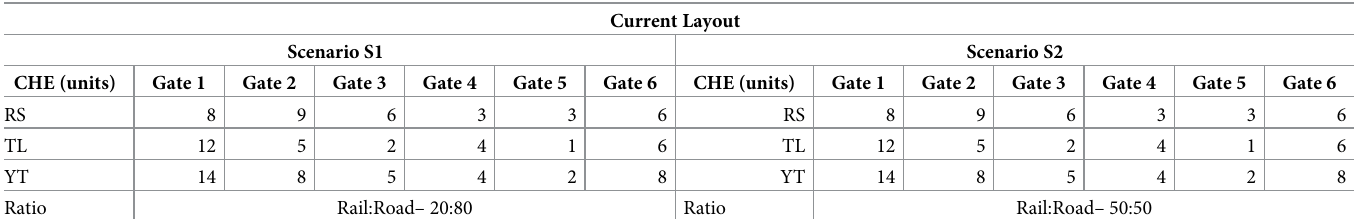
Table 2. Settings for scenarios S1 and S2 (the current LICD layout).